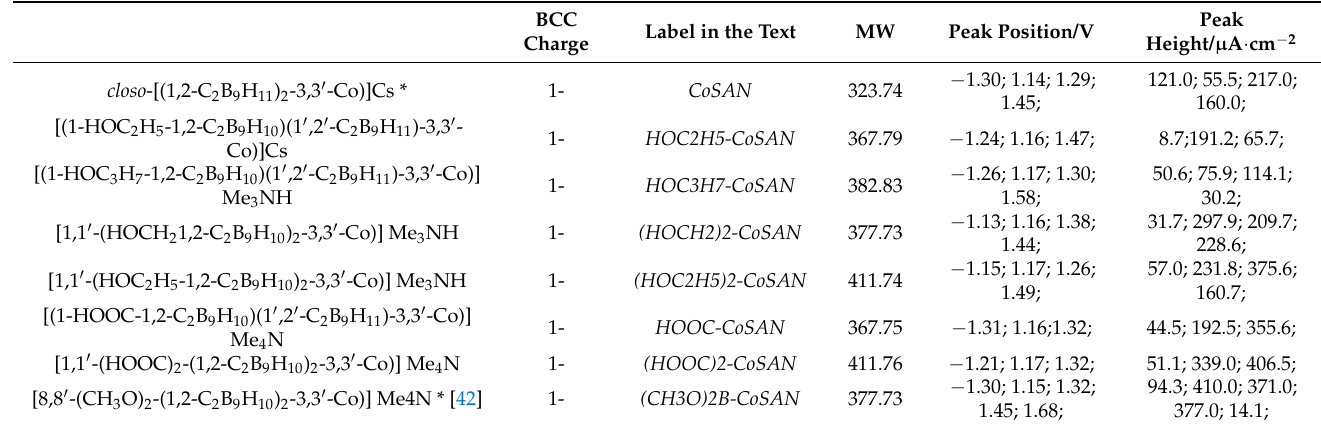
Table 1. Peak positions and heights with simple characteristics of used BCCs on GCE, pH = 8, con- centration of all metallaborates 500 µ M. For the BCCs marked * the highest achievable concentration of 500 µ M was used in the electrolyte solution.